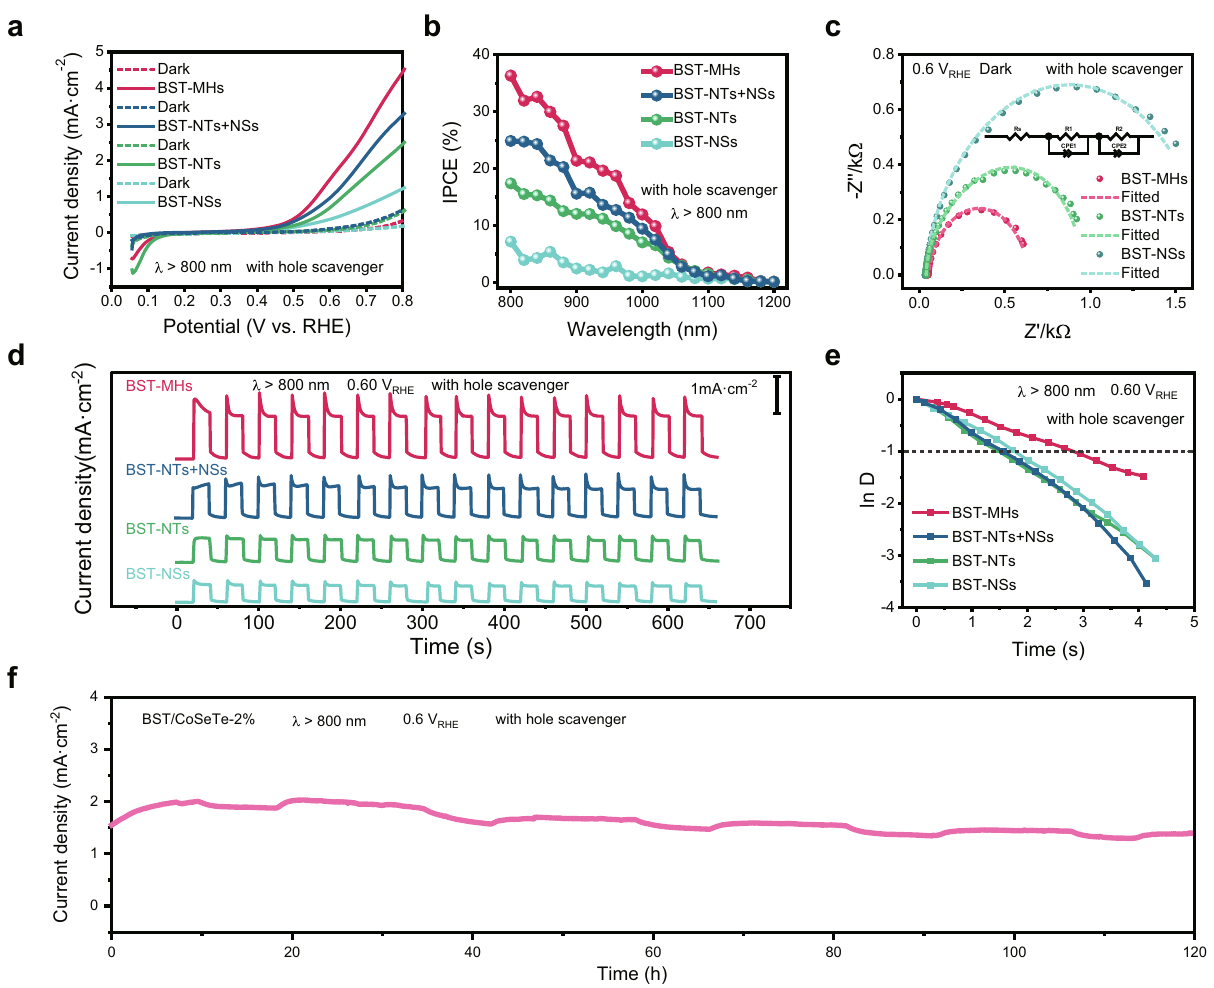
Fig. 3 PEC performance. a , b Current-potential curves ( a ), IPCEs ( b ) of the BST-MH, BST-NT, BST-NS, and BST-NT + BST-NS photoanodes under NIR light irradiation ( λ > 800 nm, 100 mWcm − 2 ). c Electrochemical impedance spectra measured for different photoanodes with hole scavengers, Z' ’ and Z'' are the real and imaginary parts of impedance. The inset shows the equivalent circuit. d , e Transient current-time curves ( d ) and normalized plots of photocurrent density-time dependence ( e ) of BST-MH, BST-NT, BST-NS, and BST-NT + BST-NS photoanodes at 0.60 V RHE under NIR light irradiation ( λ > 800 nm, 100 mWcm − 2 ). f Stability test of the BST/CoSeTe-2% photoanode at 0.60 V RHE under NIR light irradiation ( λ > 800 nm, 100 mW cm − 2 ). All experiments were measured in an electrolyte solution containing 0.08 mol L − 1 Na 2 S and 0.50 mol L − 1 Na 2 SO 3 as hole scavengers (pH =